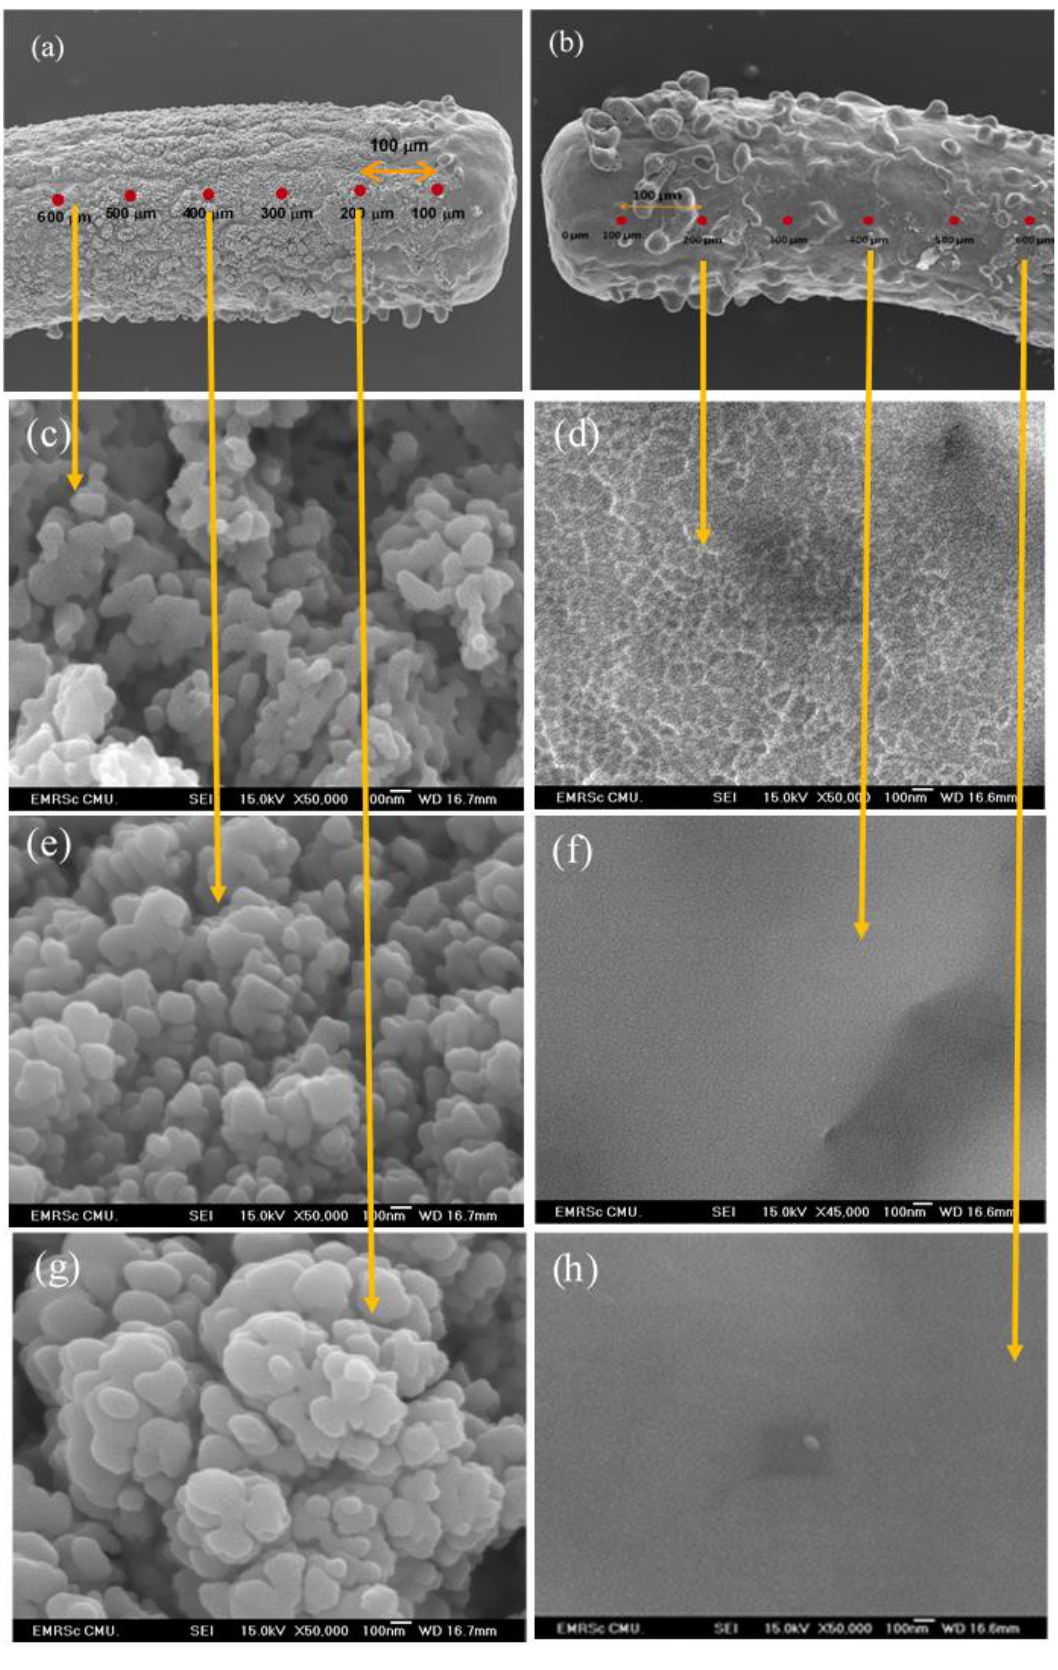
Figure 5. ( a ) Anode-Ti ( b ) Cathode-Ti after 1000 cycles of spark and surface structures on the sparked tips at the position of 200 µ m ( c , d ), 400 µ m ( e , f ) and 600 µ m ( g , h ) from the tip ends for anode and cathode titanium tips, respectively.